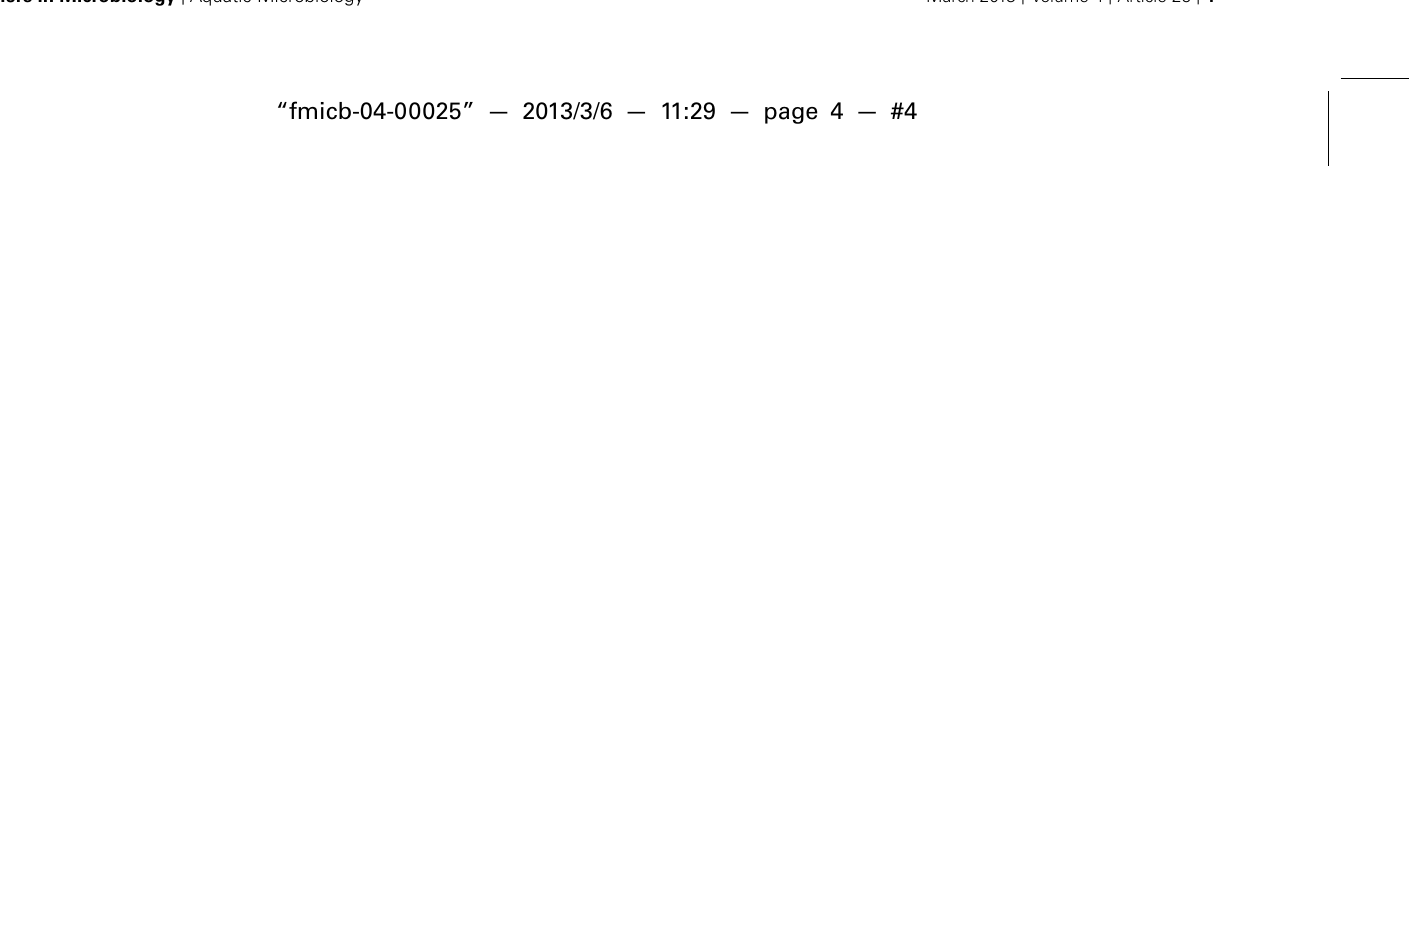
vitamin B 1 for station 11 (964.8 ± 426 pM) omitted due to concerns with possible contamination and for visualization of variation within the depth profile (average concentrations ± 1 standard deviation).Vertical lines show the detection limit (D/L) of vitamin B 1 (solid line) and B 6 (dashed